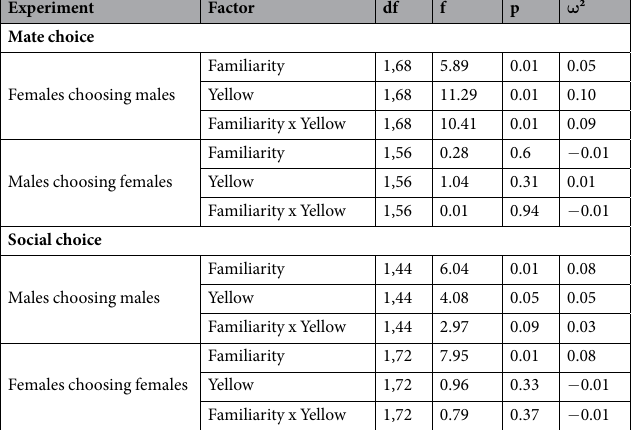
Experiment Factor df